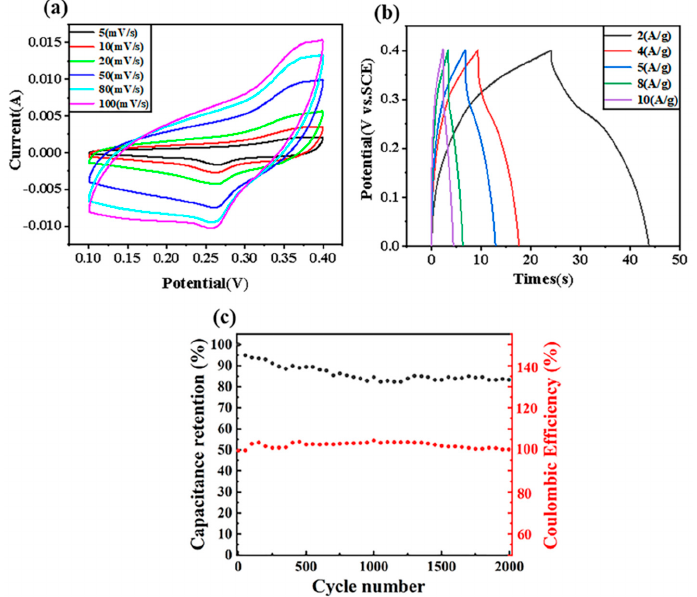
Figure 3. ( a ) The cyclic voltammetry (CV) curves of GN-1.5 electrode at scan rates of 5–100 mV s − 1 . ( b ) The galvanostatic charge discharge (GOD) curves of GN-1.5 electrode at current densities of 2–10 A g − 1 . ( c ) The cycling performances of GN-1.5 at 0.5 A g − 1